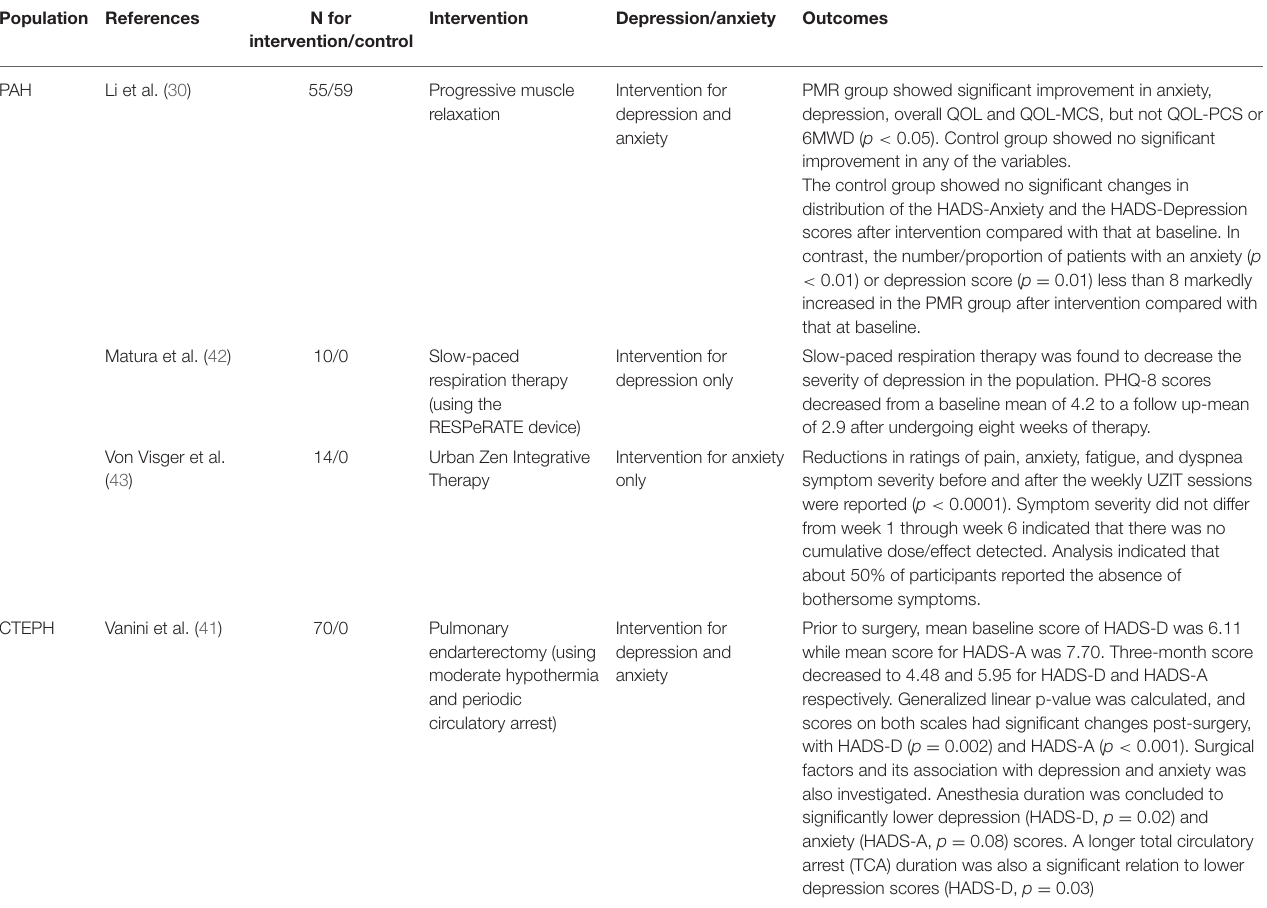
TABLE 4 | Summary of interventional studies. Population